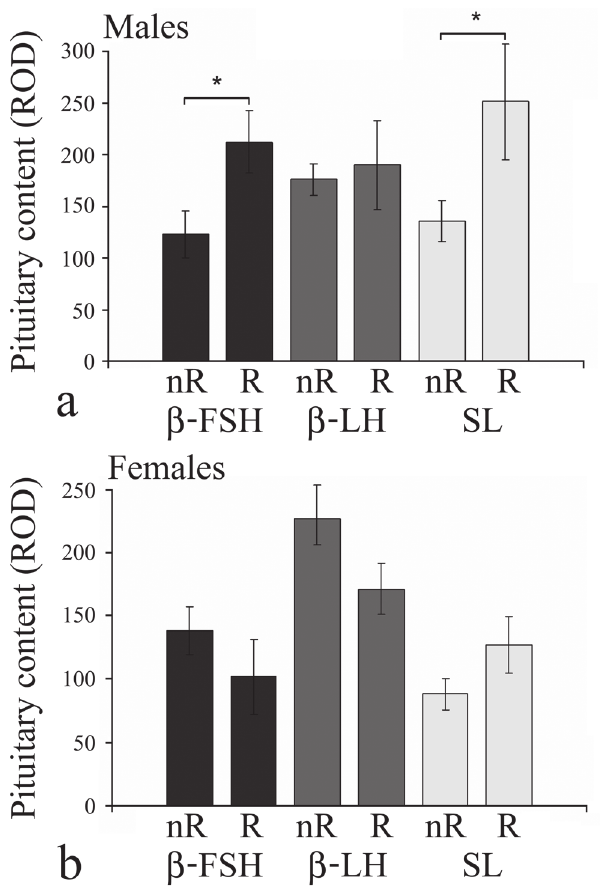
Fig. 7. Semiquantitative analysis of pituitary hormone content from reproductive (R) vs . non reproductive (nR) individuals (n = 4). Values are expressed in arbitrary units (a.u.) as means±SEM and normalized to  -tubuline. ROD = relative optical density. Asterisks indicate a statistical difference at  = 0.05 with a Mann-Whitney test. a ) Males: Greater pituitary  -FSH and SL content was observed in R males compared to nR males (p<0.05). No significant differences were observed in  -LH pituitary content between R and NR males. b ) Females: No significant differences were observed in  -LH,  -FSH, and SL pituitary content between R and nR